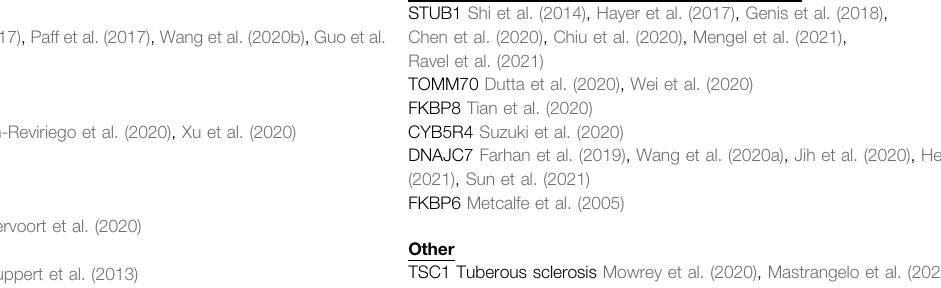
TABLE 1 | Hsp90 cochaperone-encoding genes with mutations linked to disease. Primary Ciliary dyskinesia